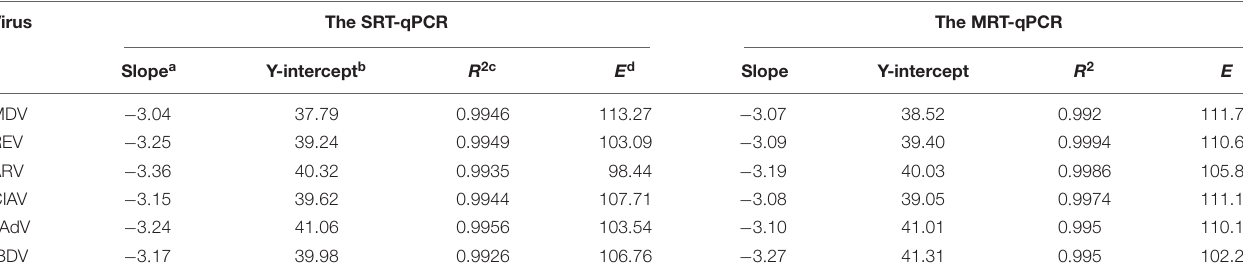
a Slopes of standard curves. b The intersection of the standard curve and the y-axis. c Correlation coefficients (R 2 ) of standard curves. d Amplification efficiencies (E) of the SRT-qPCR and MRT-qPCR assays.